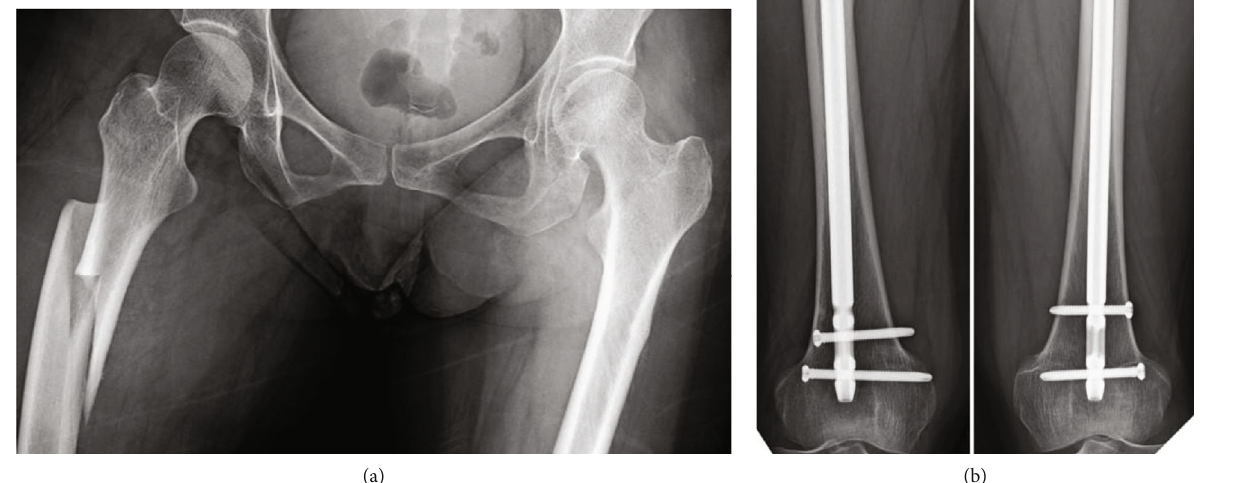
Figure 4: Both femur roentgenograms of case 4 at the time of injury (a) and fi nal follow-up (b). There were no curvatures at both femoral